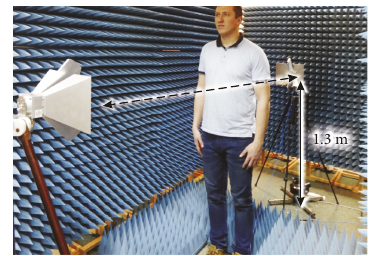
Figure 3: The measurement setup.